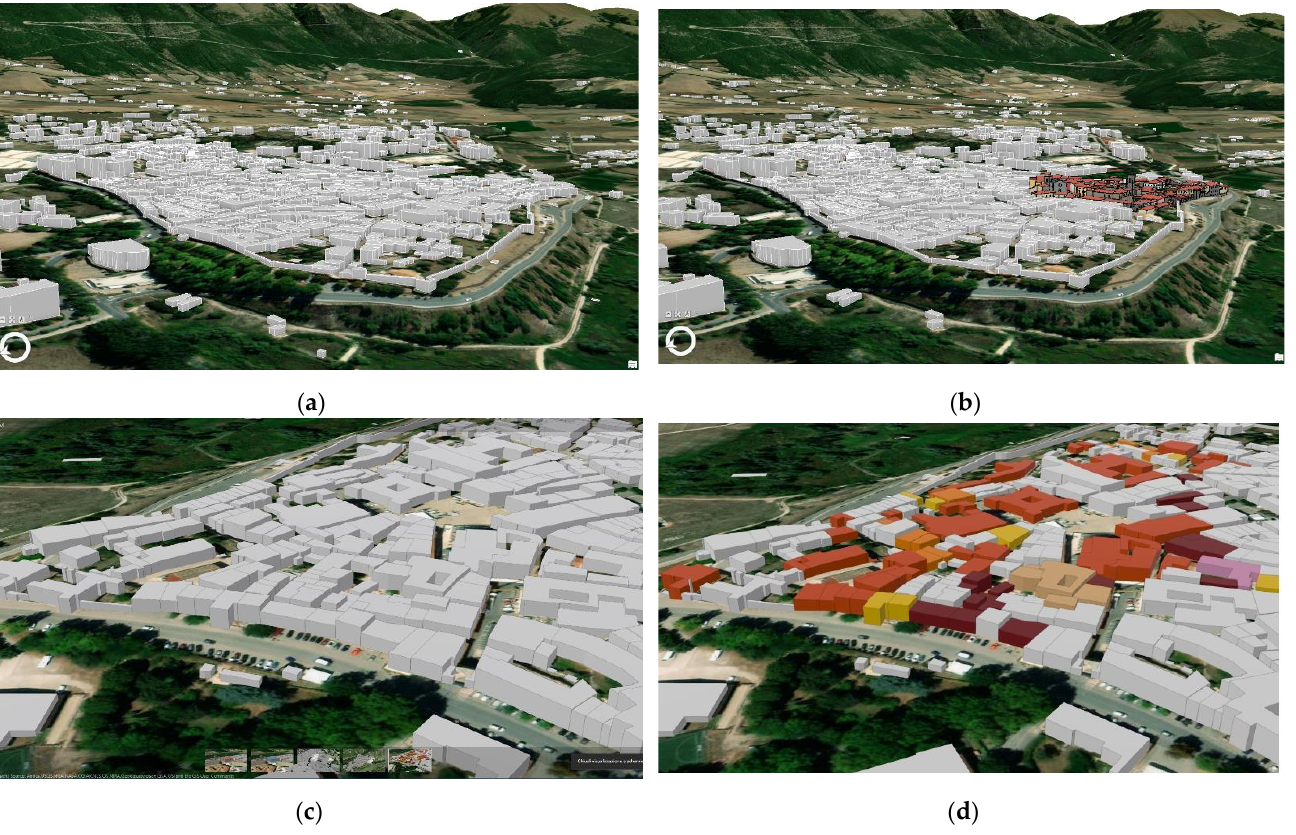
Figure 7. The LoD1 3D model generated from urban cartography in GIS interface: ( a ) neutral repre- Figure 7. The LoD 1 3D model generated from urban cartography in GIS interface: ( a ) neutral sentation; and ( c ) its zoom; ( b ) multi scale view with the LoD3 modelled part on background; and representation; and ( c ) its zoom; ( b ) multi scale view with the LoD 3 modelled part on background; ( d ) thematic mapping according to the attribute relater to damages (AEDES reports). and ( d ) thematic mapping according to the attribute relater to damages (AEDES